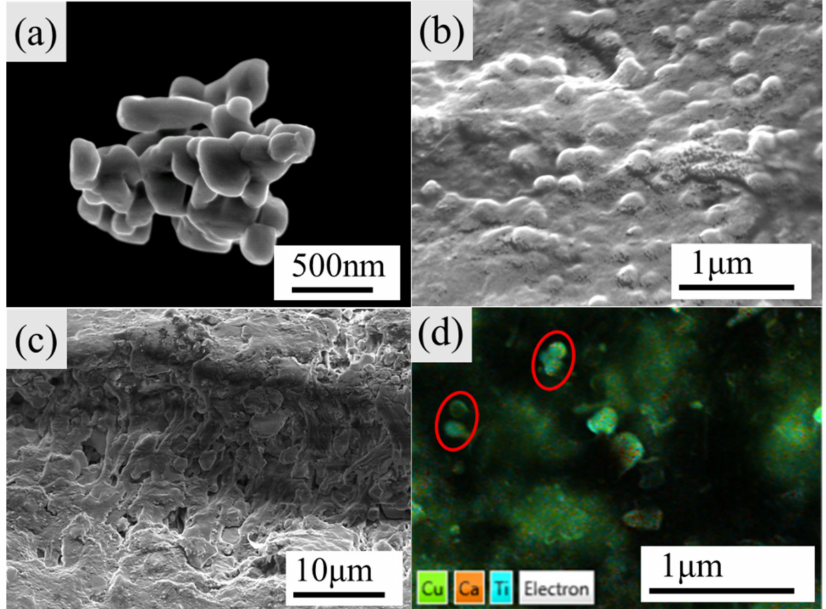
Figure 8. SEM images of sample ( a ) CCTO-1050-1 h, ( b ) surface of neat PVDF, ( c ) cross-section of CCTO-1050-1 h@PVDF composite (40 vol%), and ( d ) EDX mapping of surface of CCTO-1050-1 h@PVDF composite (40 vol%), the red circles present the CCTO particles.